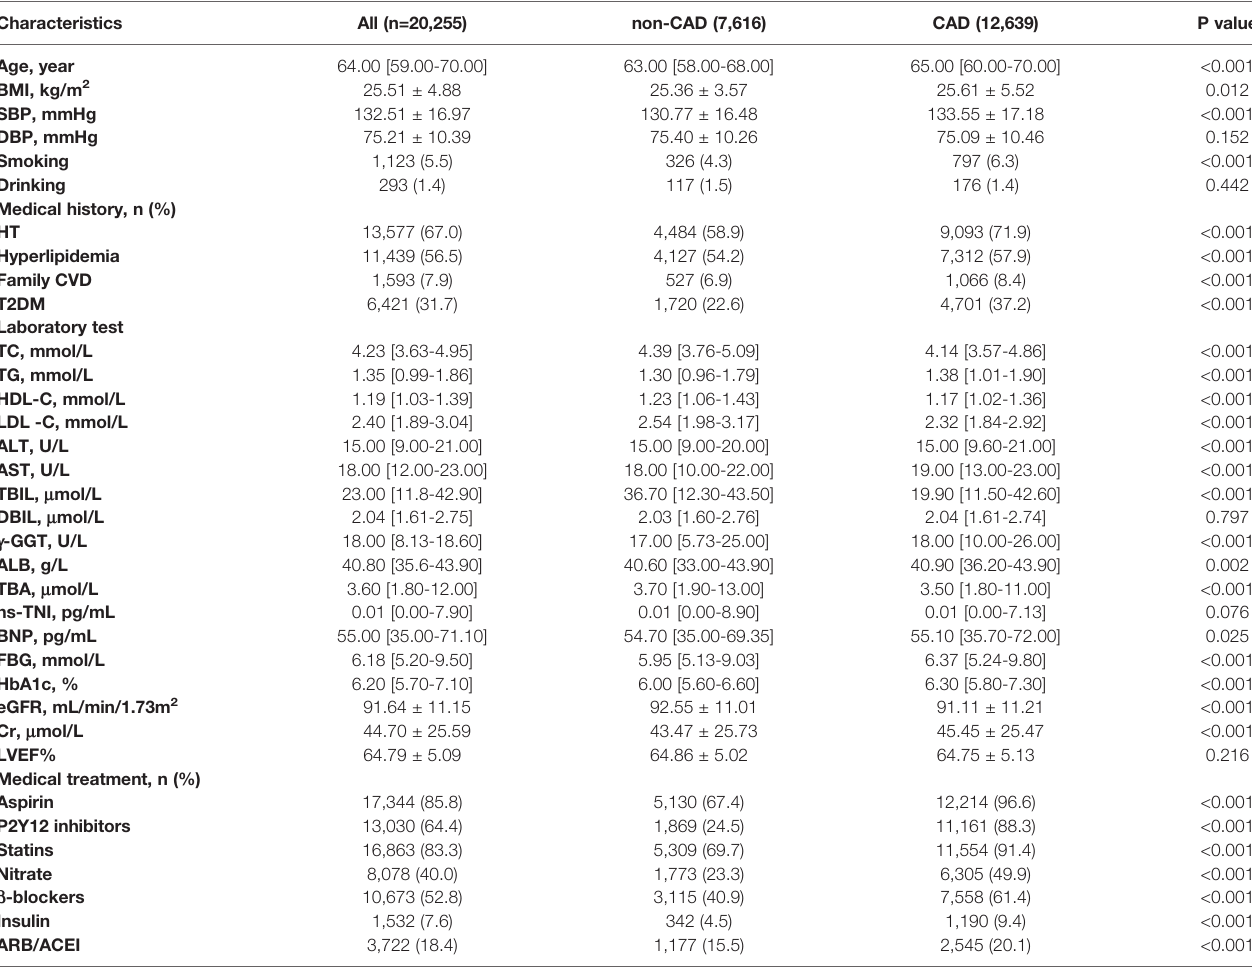
TABLE 1 | Baseline characteristics in overall population. Characteristics All